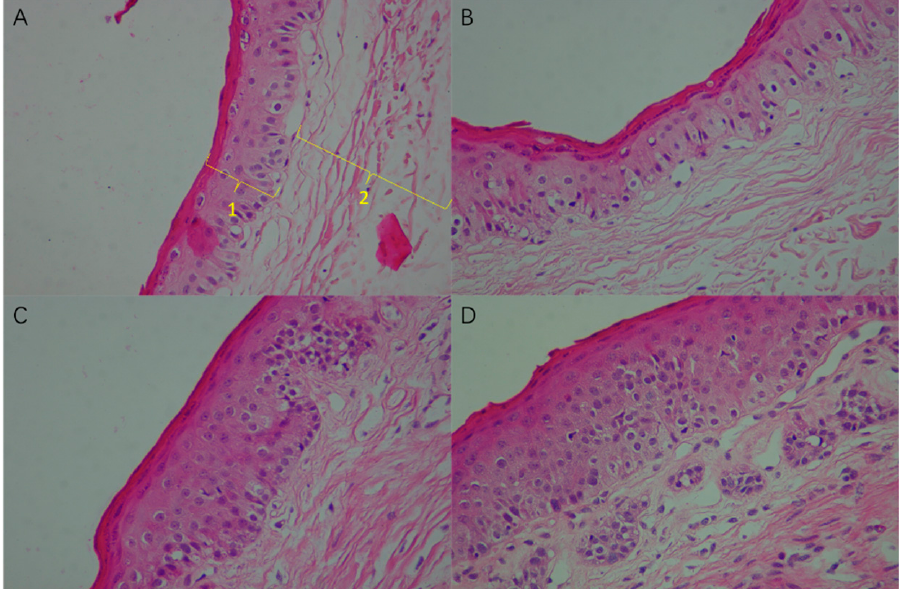
Figure 7. Effect of high sulfur diet on the morphology of rumen papilla (4 × 10 multiple microscope). ( A ), CON group; ( B ), LAS group; ( C ), MAS group; ( D ), HAS group. Epithelium cells (the black spots and red edge) arranged orderly ( A , B ) but became messy ( C , D ) with the increasing sulfur addition levels, which lead to increase the length of the epithelium. 1, cuticle and granular layer; 2, spinous layer and basal layer.